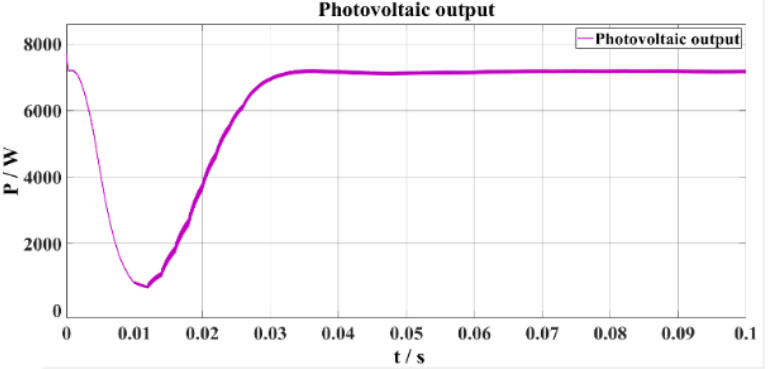
Figure 12. Maximum power point tracking.